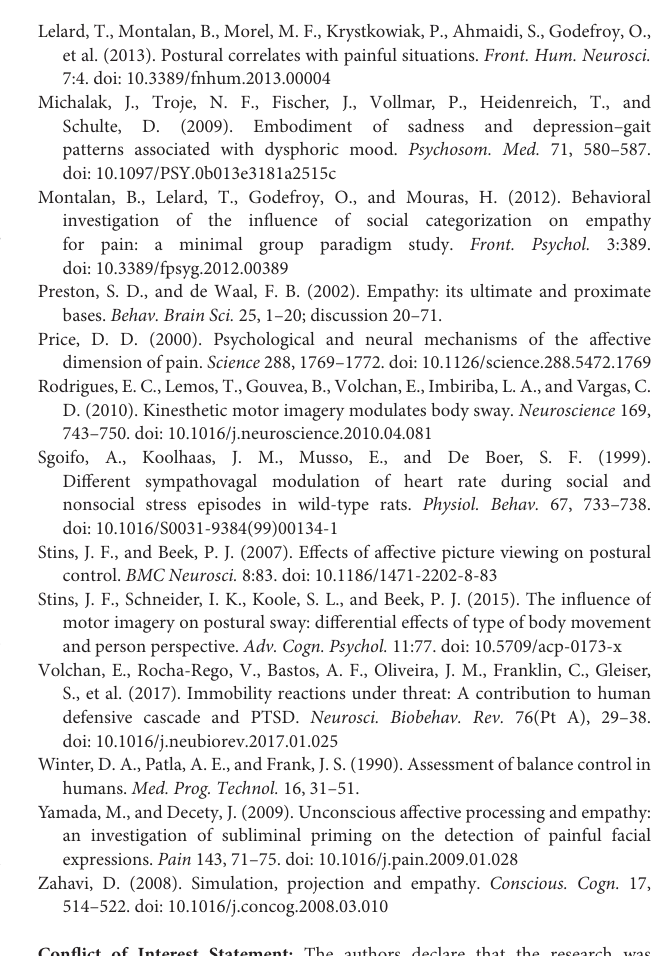
Supplementary Table1 | F -values and p -values reported for COP position in the anteroposterior direction (COP AP ), heart rate (HR), and electrodermal activity